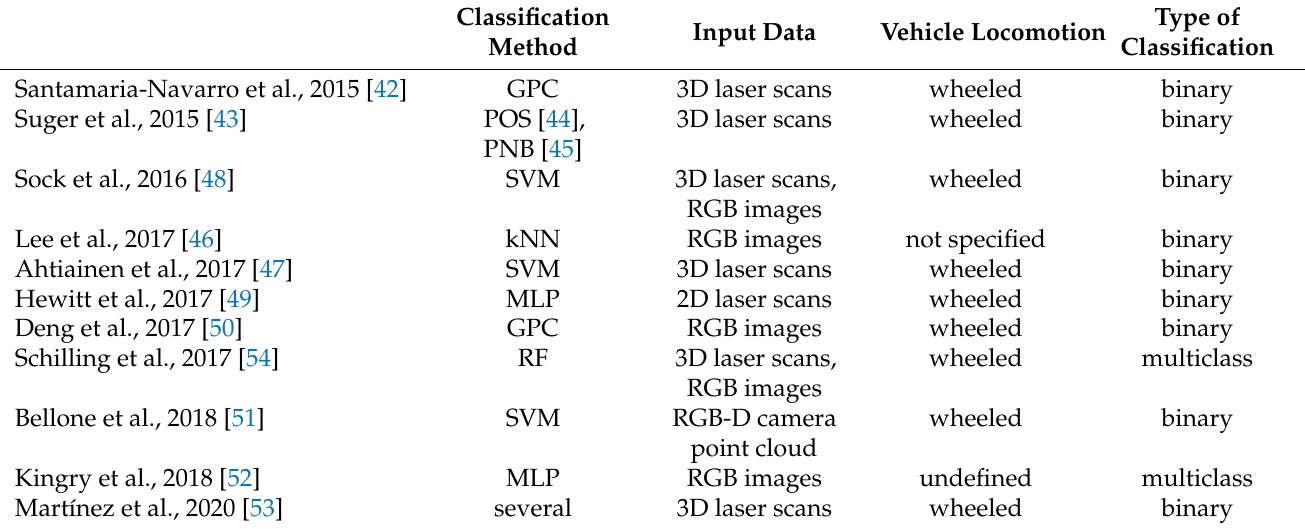
Table 3. Works on classification of terrain type with classical machine